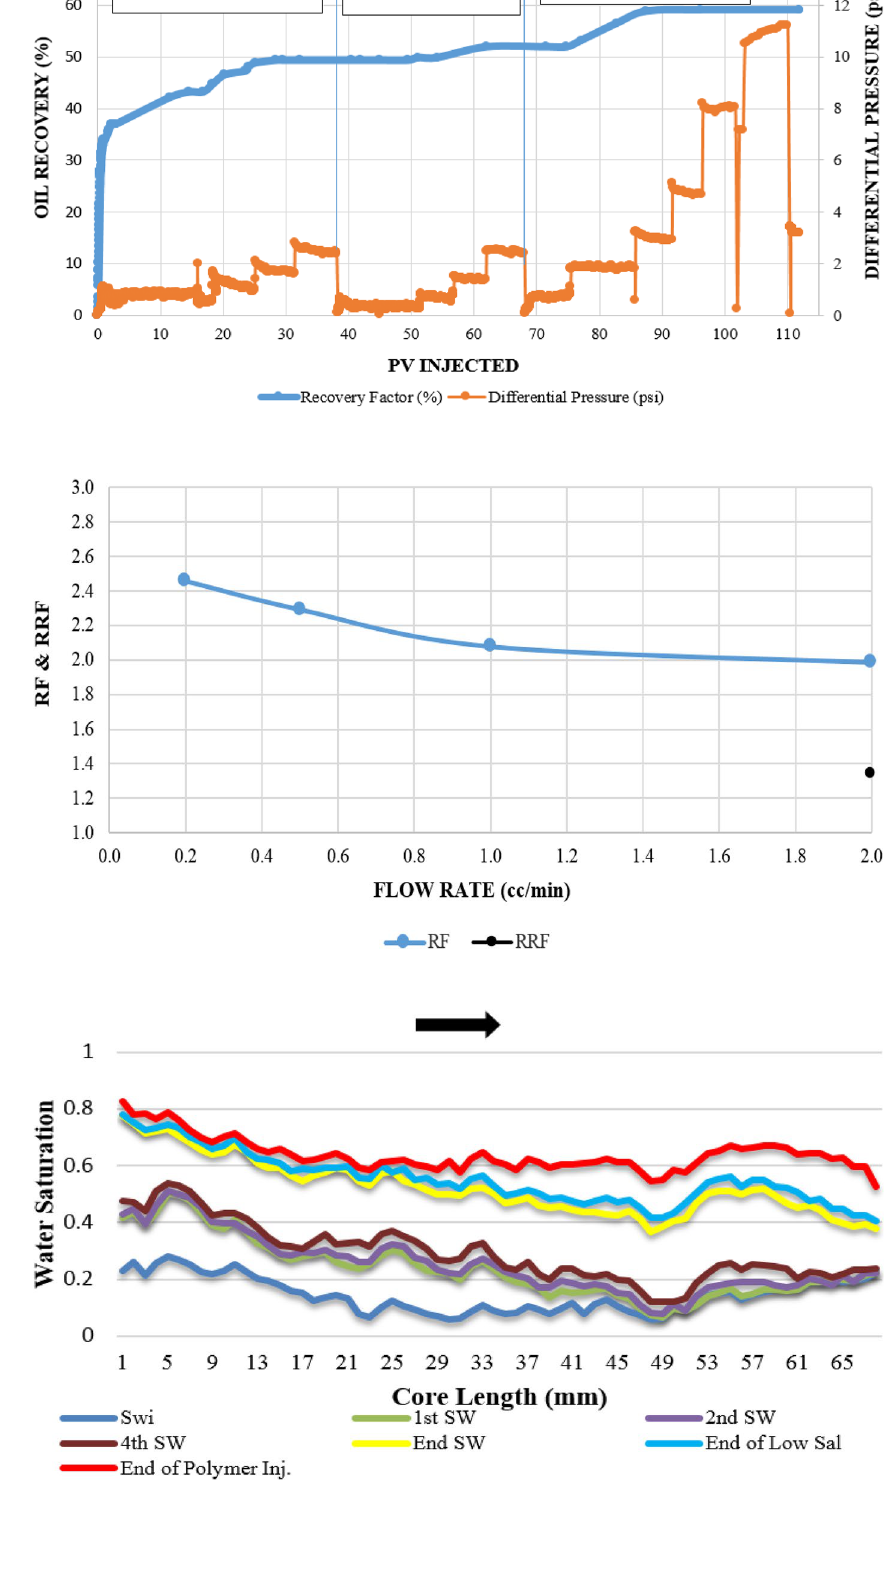
Fig. 8 Oil recovery factor (%) and differential pressure vs PV injected during oil recovery of Exp. 2